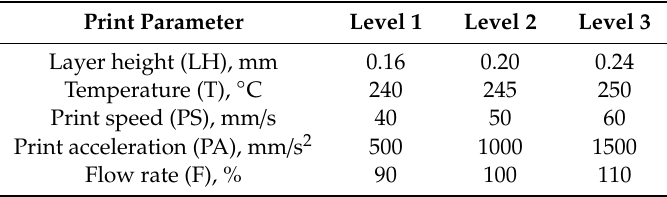
Table 1. Factors and levels used in design of the experiments (DOE).